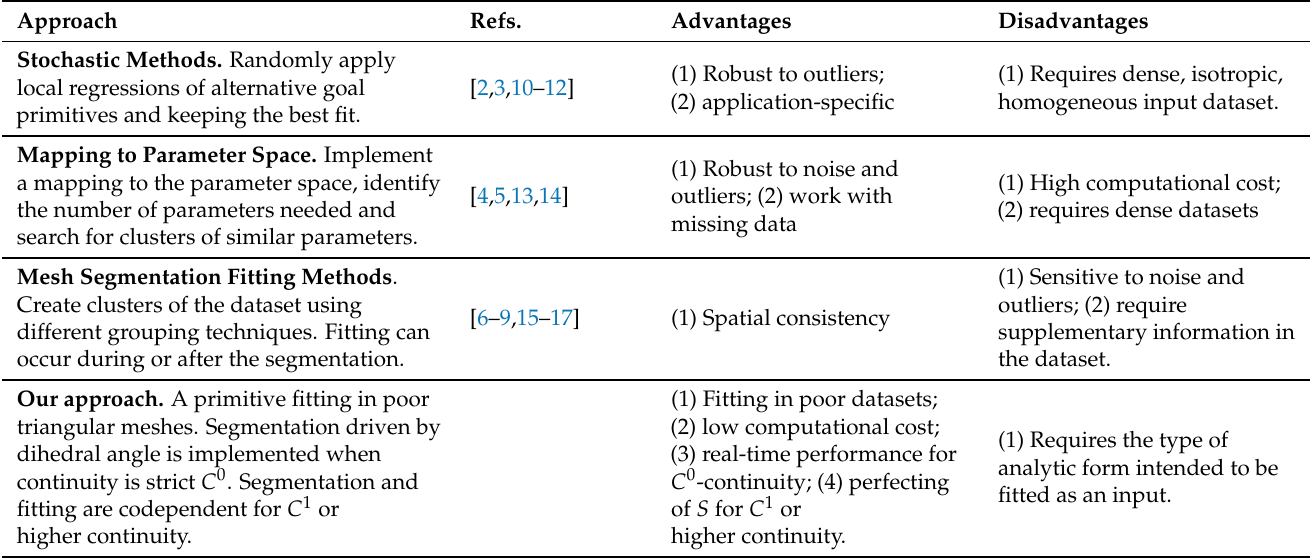
Table 1. Competitor approaches vs. current approach.